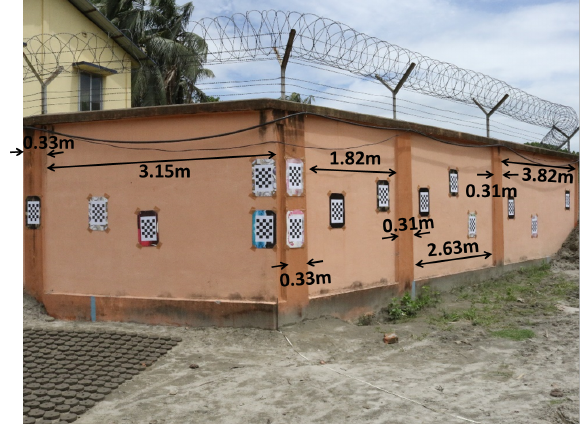
Figure 5. Details of the site location of 55° corner